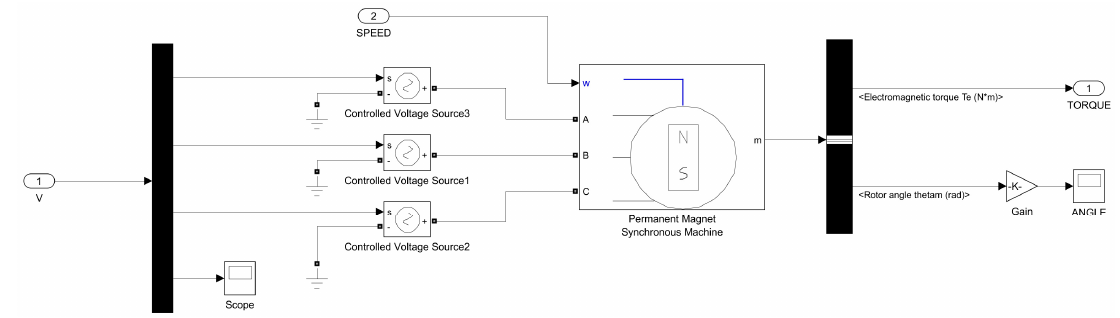
Figure 5. The DC motor subsystem in the Simulink model.